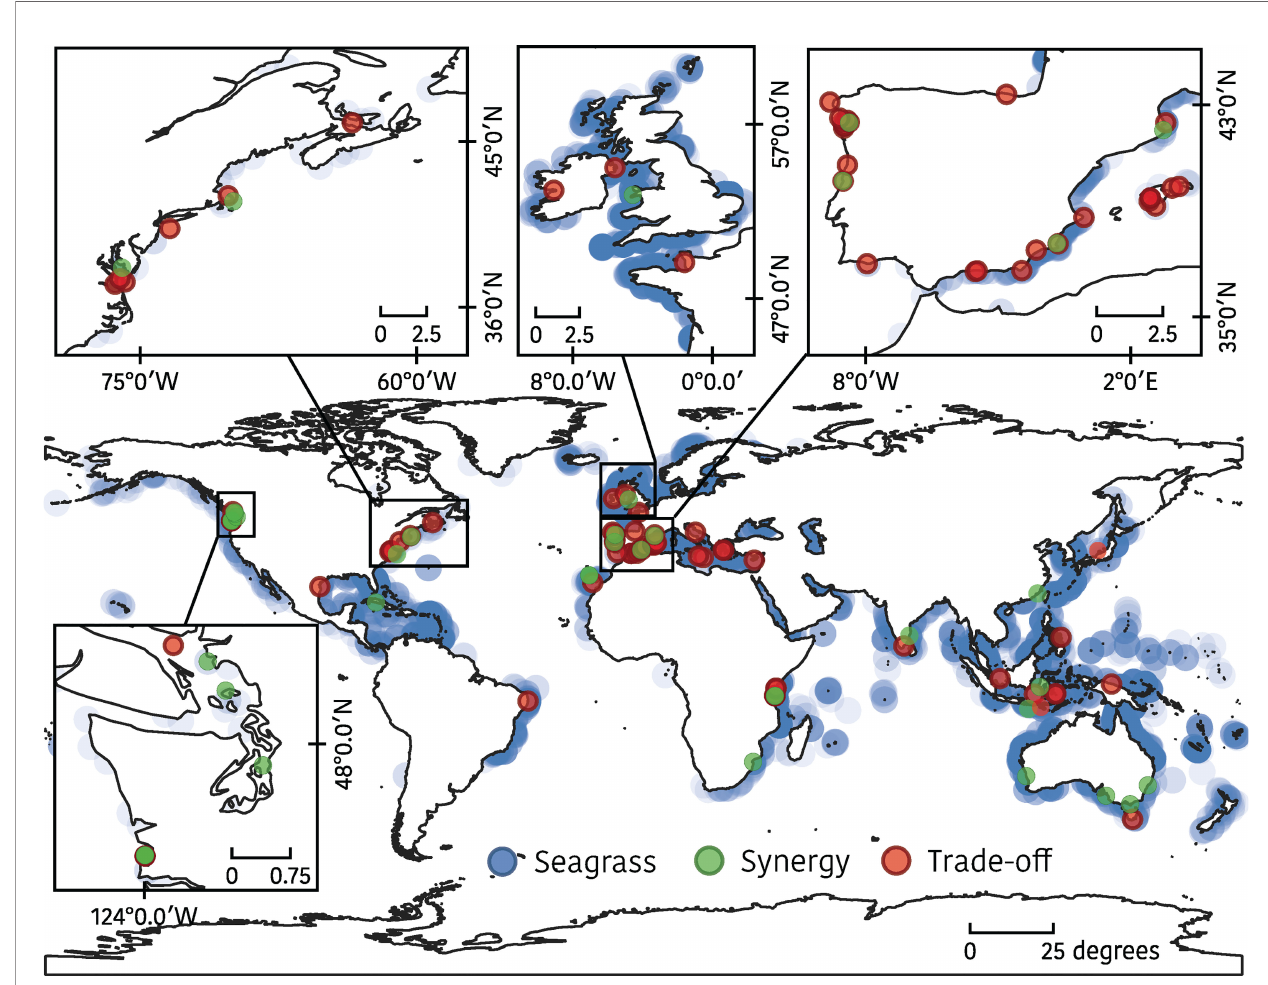
FIGURE 3 | Geographical distribution of publication ’ study sites. Trade-offs are shown in red and synergies in green (N=89). Global seagrass distribution is shown in blue (UNEP-WCMC and Short, 2021). Global reviews are not included to avoid